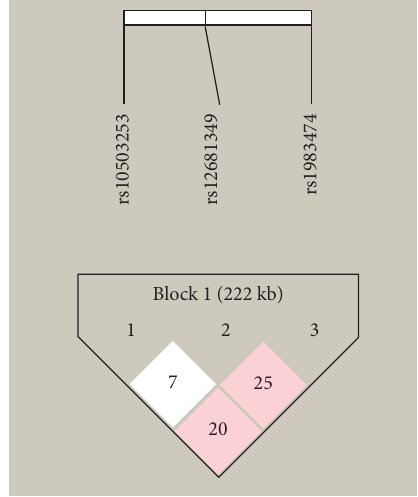
Figure 2: Analysis of linkage disequilibrium between case group and control